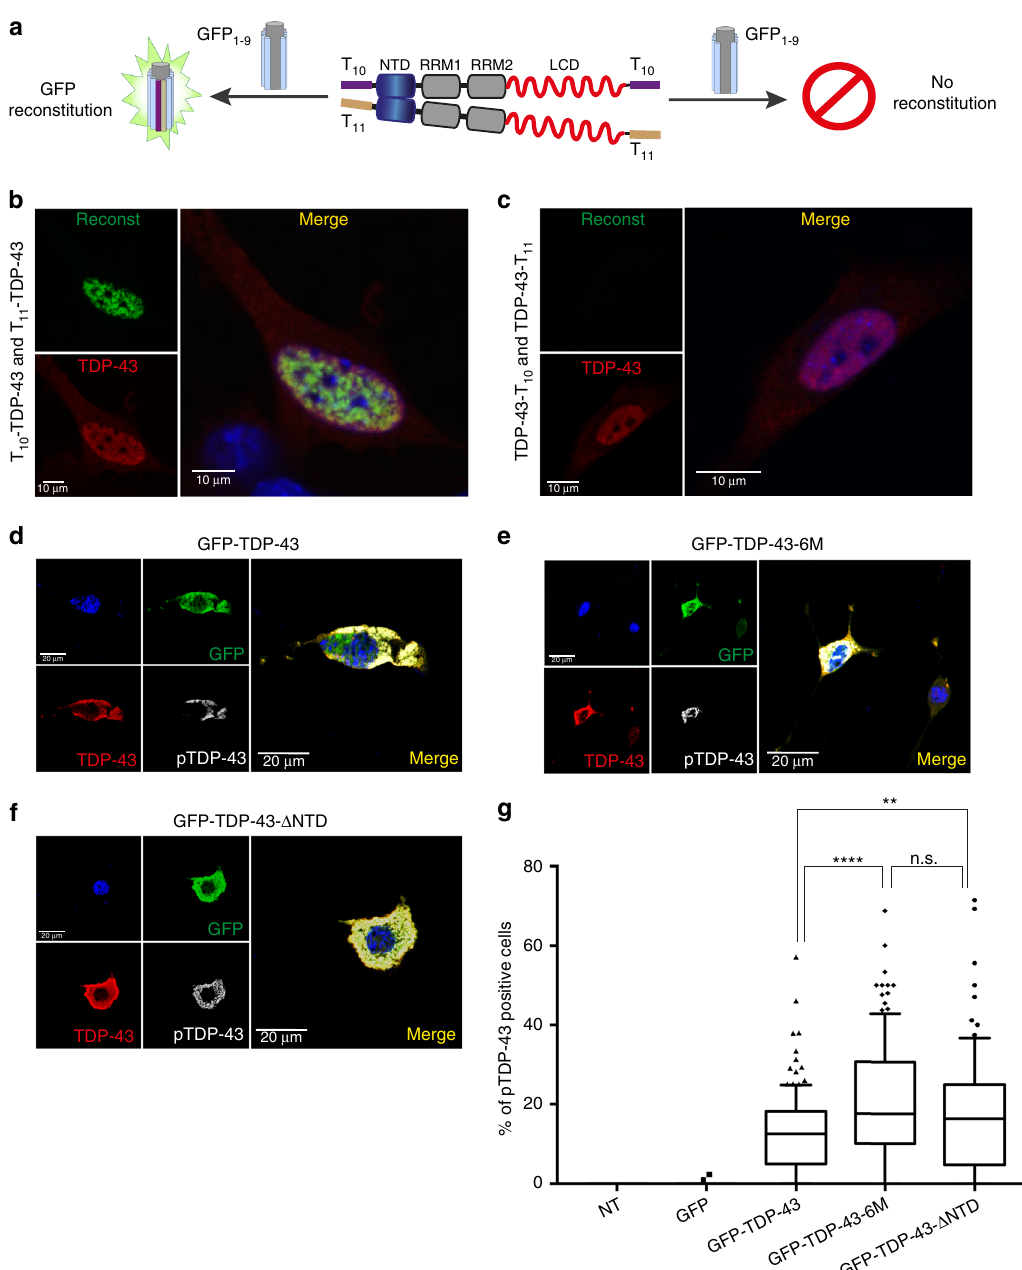
Fig. 6 NTD-mediated TDP-43 oligomerization impedes inter-molecular LCD interactions and antagonizes pathologic protein aggregation. a Schematic of tripartite GFP complementation assay. TDP-43 was tagged either at the N- or C-terminus with the 10th (T 10 ) or 11th (T 11 ) β -strand of GFP (schematically indicated in magenta and light yellow , respectively). Successful complementation results in fl uorescence reconstitution with GFP 1-9 molecule (GFP β -strands 1 – 9 shown in blue and α -helix in grey ). b , c N- b or C-terminally c tagged T 10 - and T 11 - TDP-43 were co-transfected with GFP 1 – 9 in mouse C17.2 cells. Confocal microscopy analysis on cells shows successful complementation as fl uorescence reconstitution in case of N-terminally tagged T 10 - and T 11 - TDP-43 b . In contrast, the C-terminal tagged T 10 - and T 11 - TDP-43 fail to reconstitute fl uorescence c . Merged and zoomed in images are shown on the right . Transfected mouse C17.2 cells were counter-stained with a human-speci fi c TDP-43 antibody ( red ) and the nuclear marker DAPI ( blue ). d – f Confocal microscope images of NSC-34 cells overexpressing GFP-tagged wild type d or oligomerization defective TDP-43 mutants e , f . Cells were stained with anti-GFP ( green ), anti-TDP-43 ( red ) and anti-phosphorylated TDP-43 ( gray ) antibodies. Merged images overlaid with DAPI ( blue ) are shown on the right . g The percentage of phosphorylated TDP-43 (pTDP-43)-positive cells is plotted for wild-type and oligomerization mutant TDP-43 (TDP-43-6M and TDP-43- Δ NTD). Manual cell counting was conducted on confocal images (20× magni fi cation). For each condition, approximately 2500 GFP-positive cells (or 1500 cells for GFP-TDP-43 Δ NTD) from three biological replicates were counted by an investigator that was blinded to the identity of the samples. Percentage of phosphorylation was determined considering the total number of GFP-positive transfected cells. An unpaired student t -test was performed to determine signi fi cance (depicted as asterisks ). P -values: WT vs. 6 M: < 0.0001 (****), WT vs. Δ NTD: 0.003 (**), 6 M vs. Δ NTD: 0.184